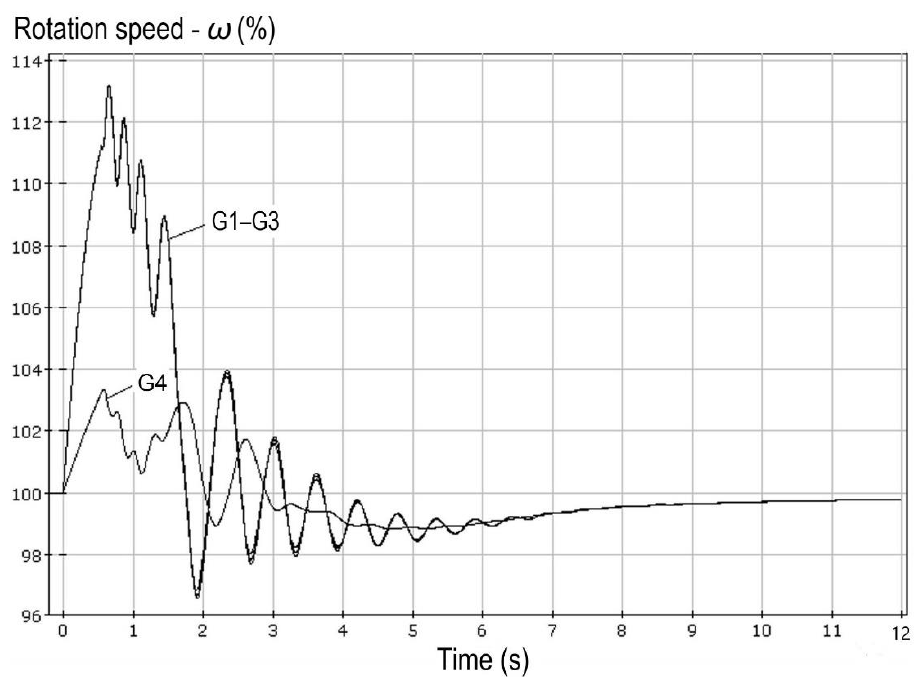
Figure 5. A transient process similar to that in Figure 3, but with a 20% share of induction motors at the load nodes.